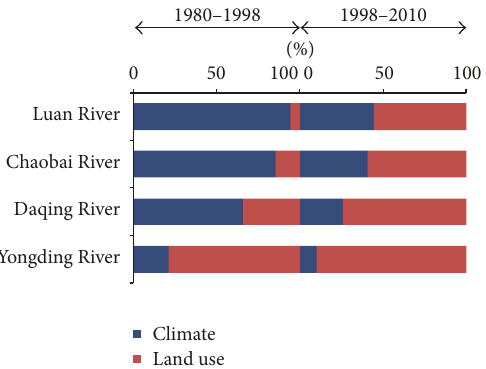
Figure 6: The contributions of climate and land-use changes to the variation in runoff in subbasins before and after the runoff change point (1998). The blue bar represents the contribution of climatic factors on the decrease in runoff, and the red bar represents the contributionofland-usefactors.Thestatisticalsignificancewas <